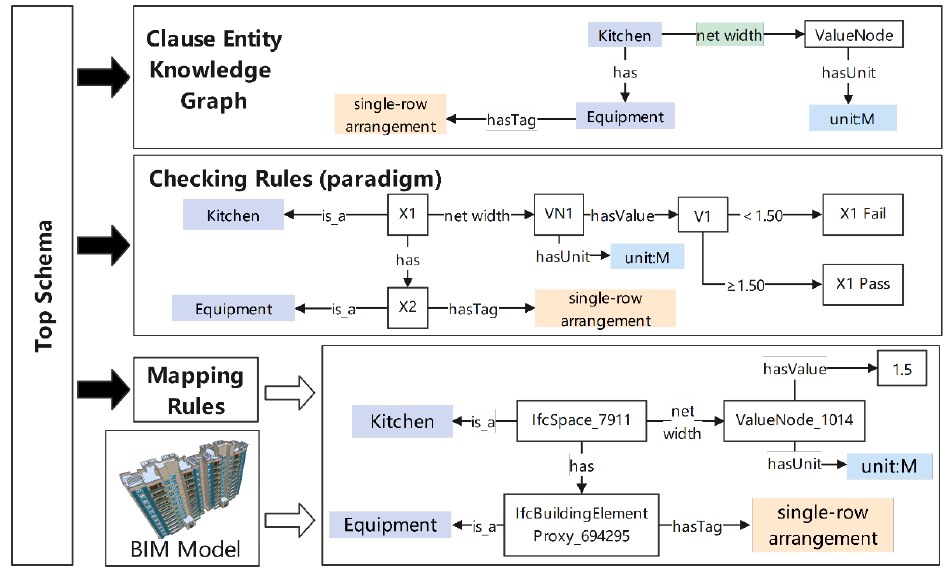
Figure 4. The proposed top schema is the basis of the development of clause-entity knowledge graphs, mapping rules, and checking rules.